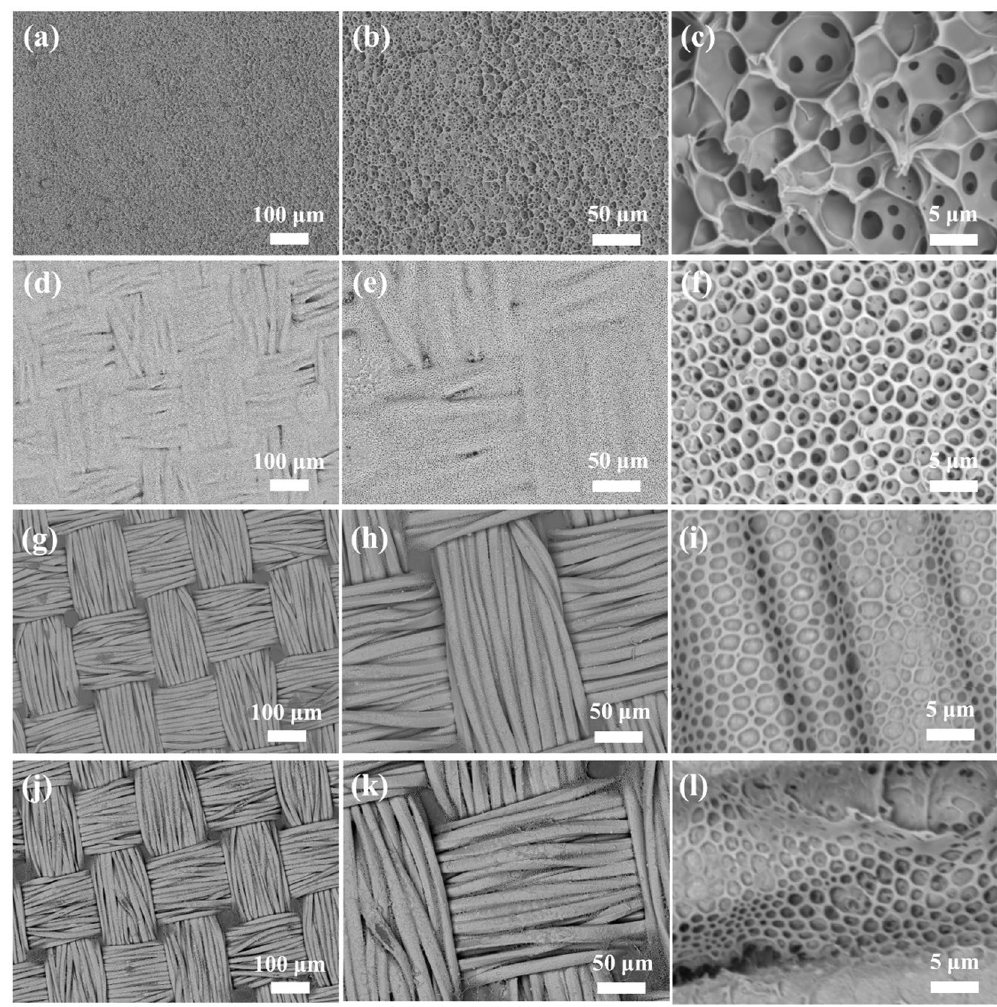
Figure 3. The influence of solution concentration on the formation of CPMFs: ( a–c ) 60.0 mg, ( d–f ) 30.0 mg mL − 1 , ( g–i ) 7.5 mg mL − 1 , and ( j–l ) 3.0 mg mL −